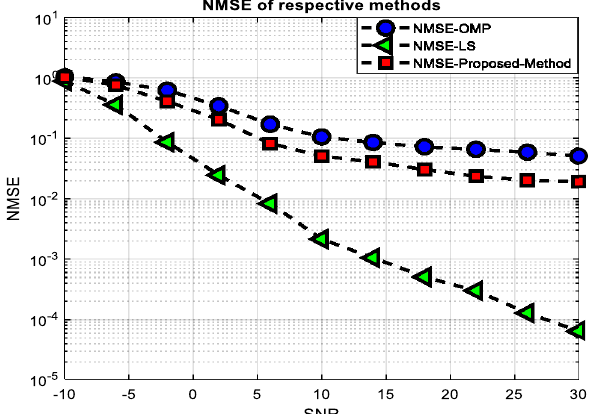
Figure 3. NMSE performance versus the SNR.